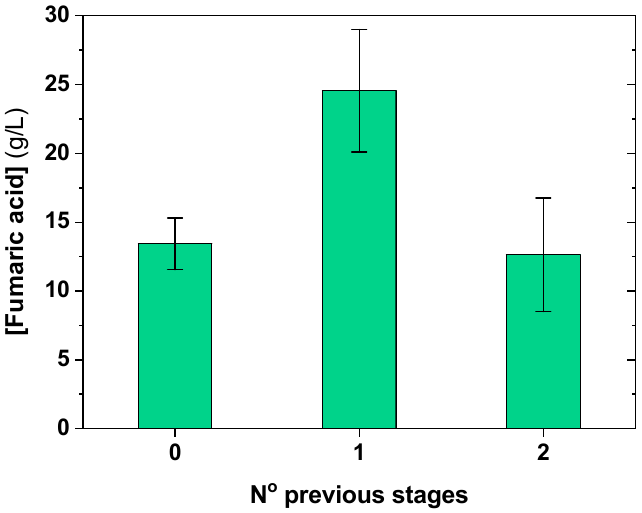
Figure 5. Number of previous stages determination.